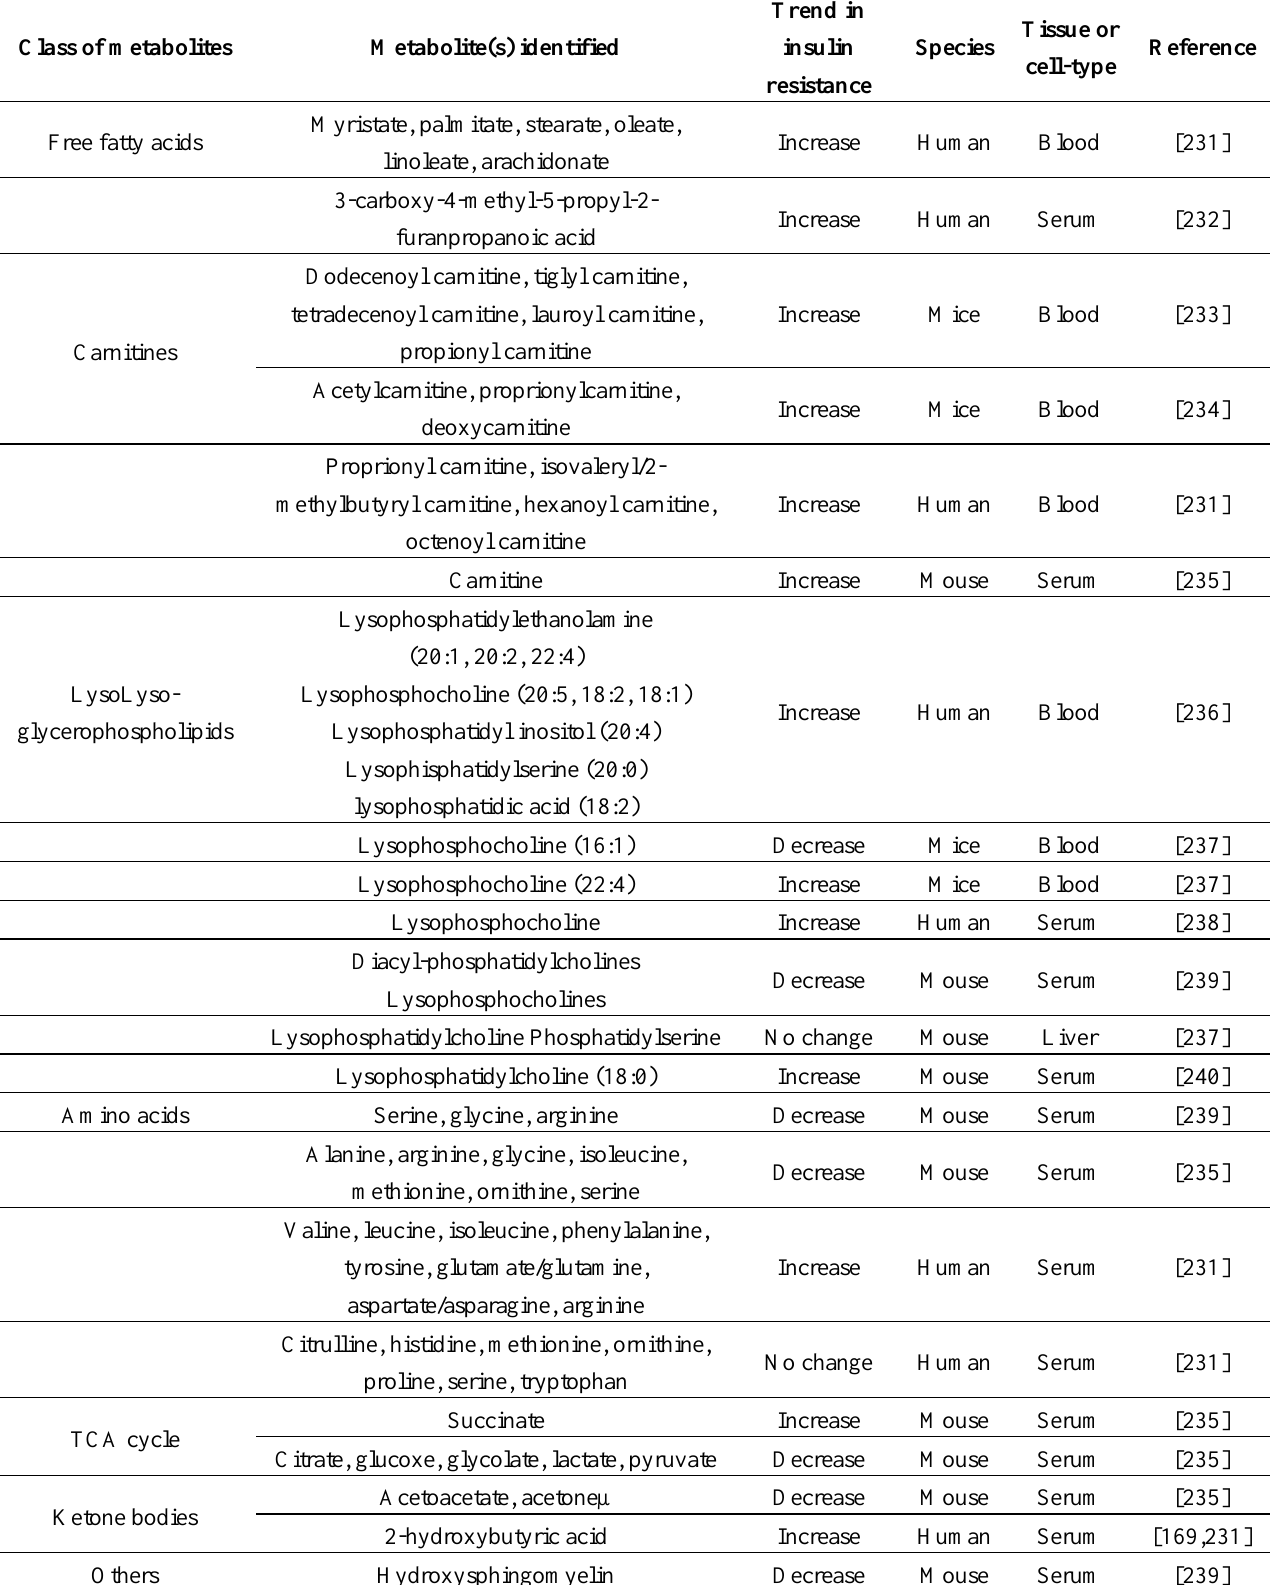
Table 2. Summary of metabolites found as modified in response to insulin